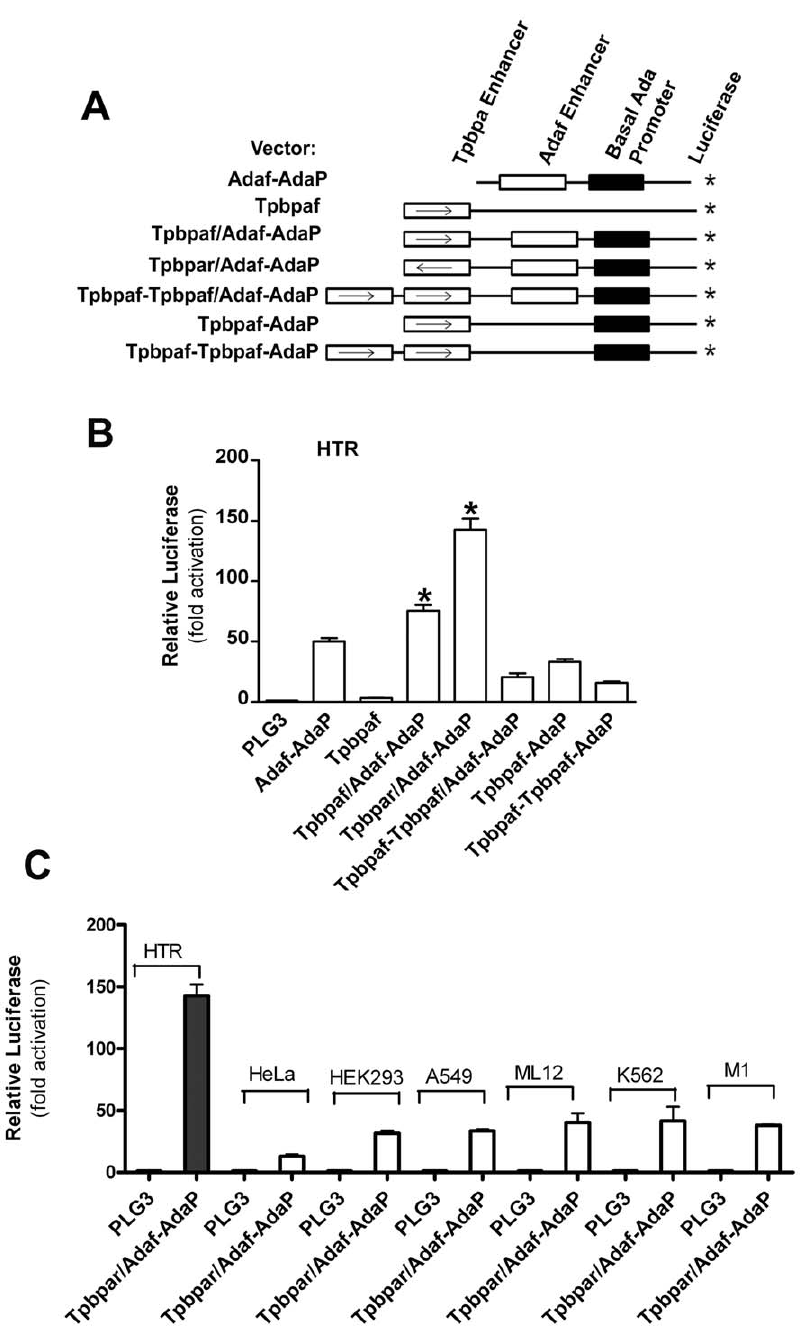
Figure 1. Random assembly of placental specific enhancers and invitro analysis of their ability to activate the basal promoter of the Ada gene in multiple cell types. ( A ) Schematic illustrations of the constructs. ( B ) Luciferase activity in human trophoblast (HTR) cells transfected with each construct. ( C ) Luciferase activity driven by Tpbpa r/ Ada f- Ada P chimeric enhancer in multiple cell lines. Data are expressed as mean 6 SEM. n=4–6. * P , 0.05 versus cells transfected with Ada f- Ada P construct.